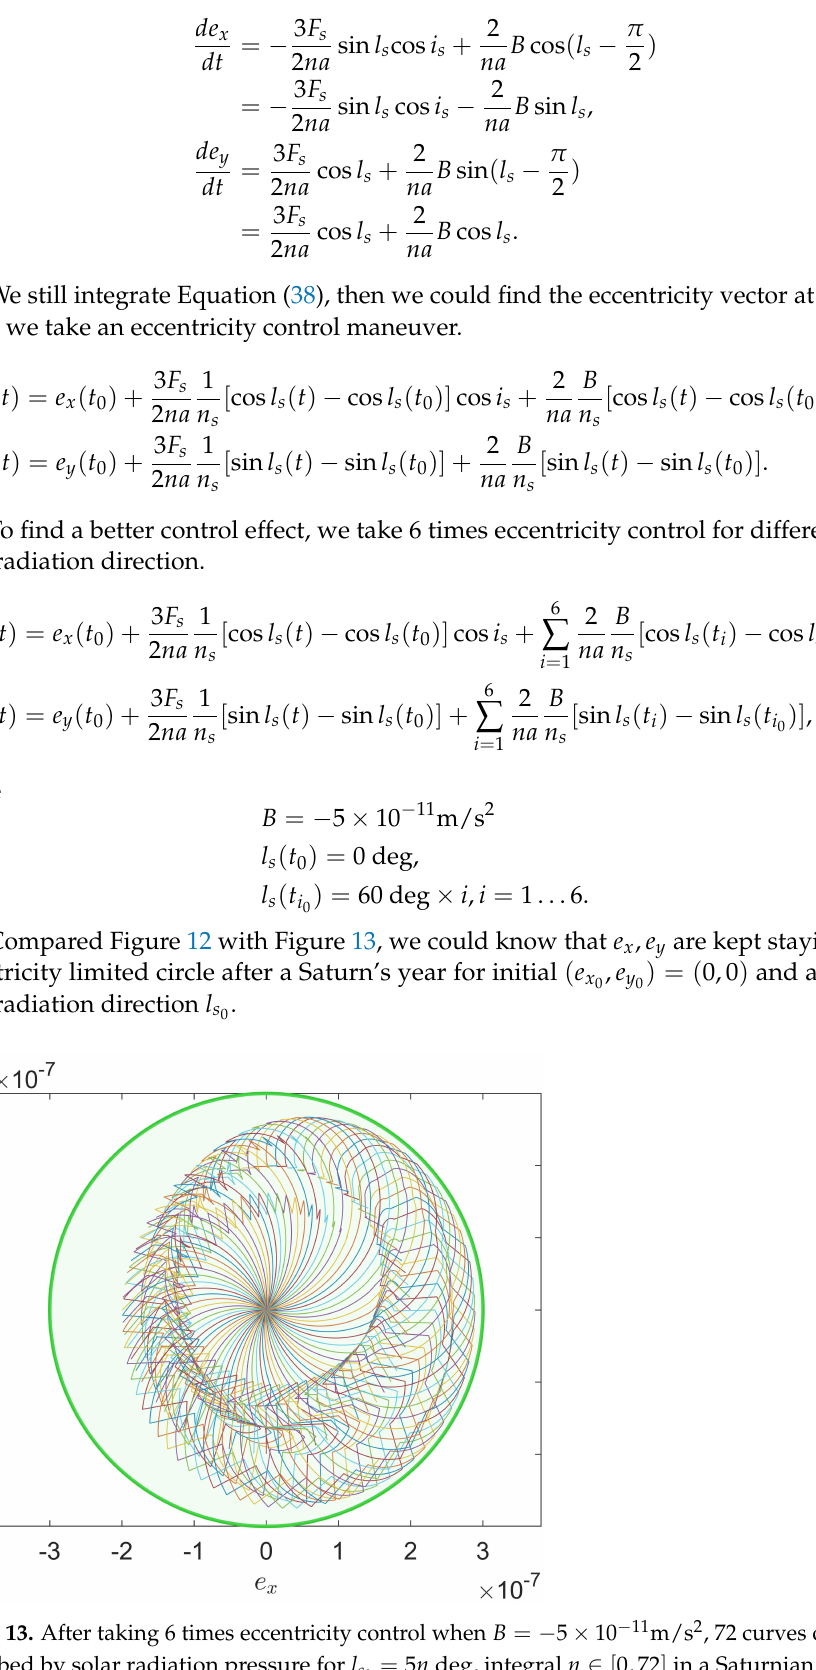
= 5 n deg, integral n ∈ [ 0,72 ] in a Saturnian year with 0 ) = ( 0,0 ) in the eccentricity perturbation limited circle whose , e y 0 0